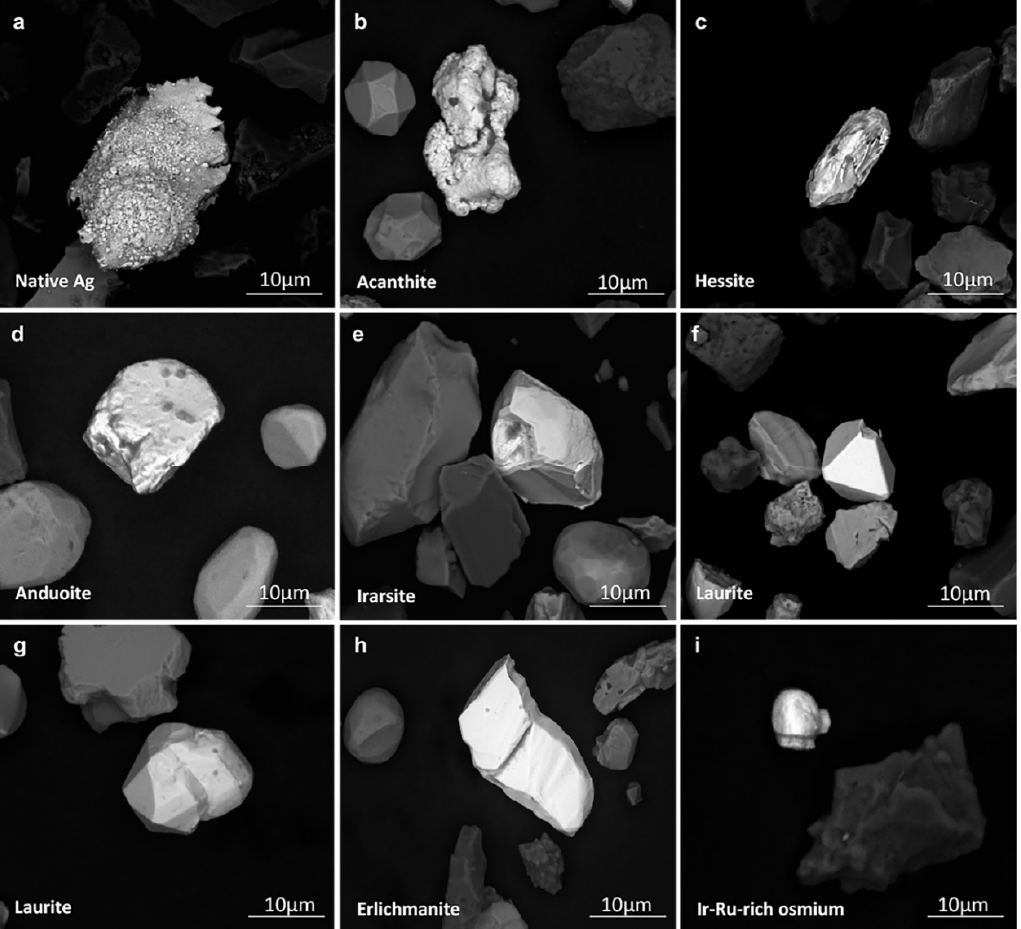
Figure 5. A selection of backscatter electron (BSE) images of precious metal minerals (PMM) including Ag-bearing phases ( a – c ) and minerals of the iridium-like platinum-group elements (IPGE-PGM) identified in the till samples processed and analyzed by IOS-SG. ( a ) Native silver (Ag); ( b ) Acanthite (Ag 2 S); ( c ) Hessite (Ag 2 Te); ( d ) Anduoite ((Ru,Os)As 2 ); ( e ) Irarsite ((Ir,Ru,Rh,Pt)AsS); ( f , g ) Laurite (RuS 2 ); ( h ) Erlichmanite (OsS 2 ); ( i ) An Ir-Ru-rich osmium grain.